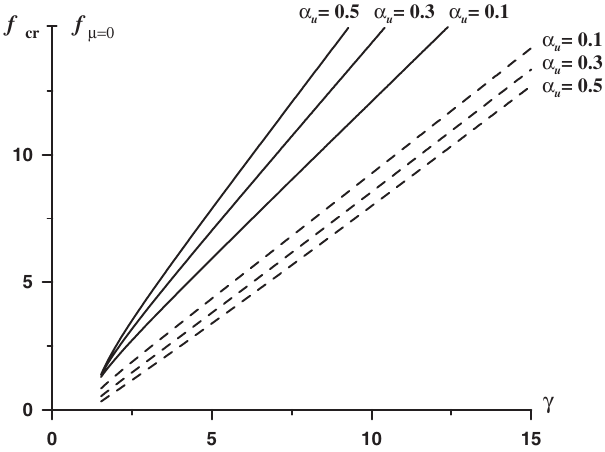
(dashed lines) and f , which cr (cid:9) ¼ 0 w